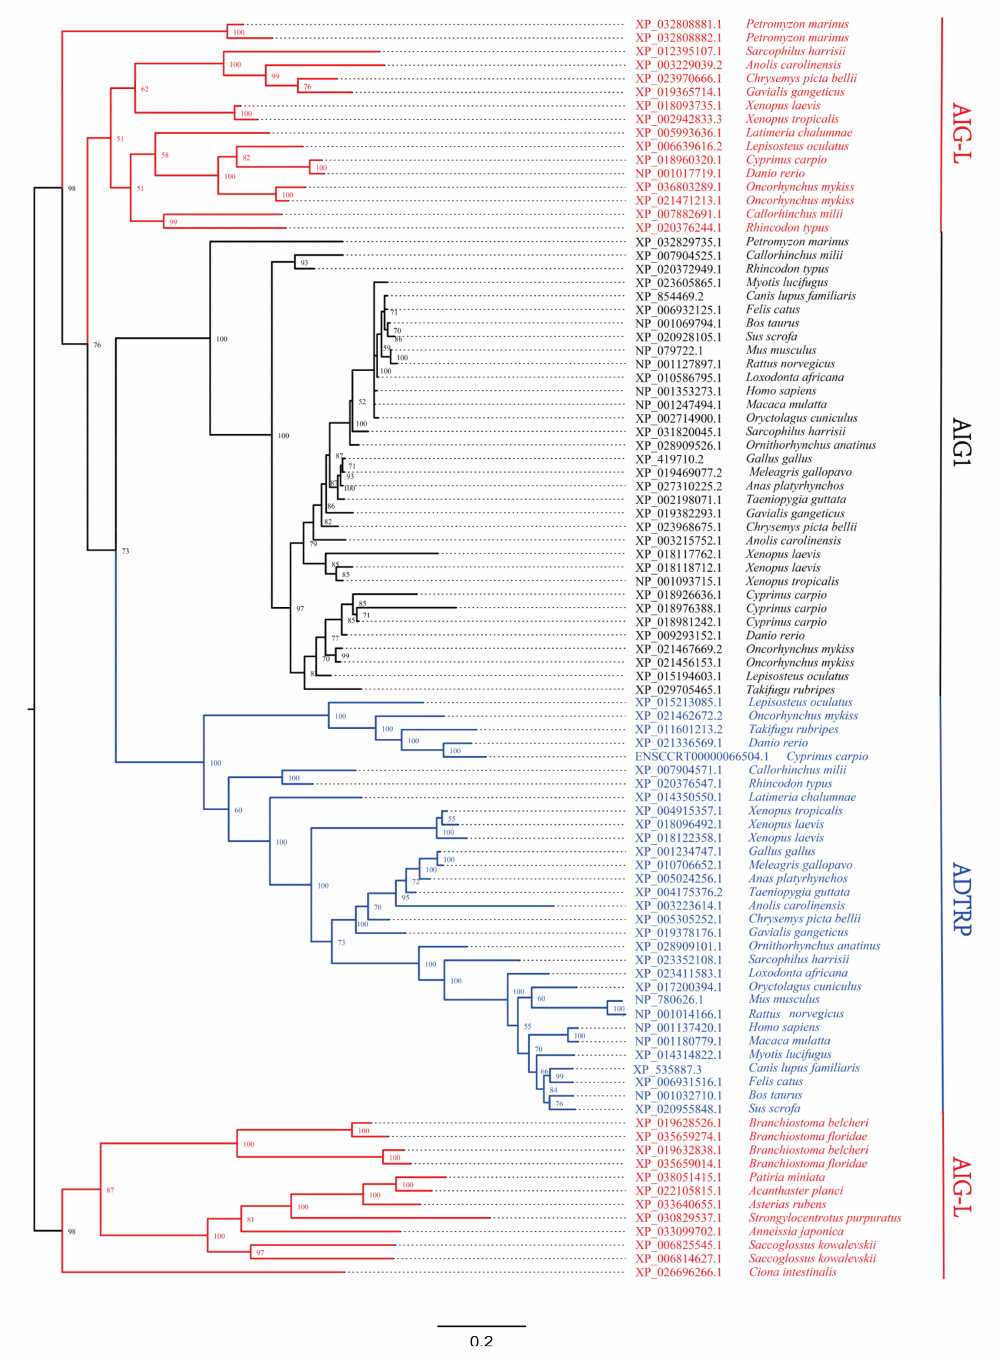
Figure 1. Phylogenetic analysis of the AIG protein sequences in representative species using Bayesian methods. The Bayesian posterior probabilities ( × 100) are shown for each node. The phylogenetic tree shows a topology with three major clades present in vertebrates. ADTRP, AIG1, and AIG-L are highlighted in blue, black, and red, respectively. Invertebrate AIG-L, which is in red, was used to generate an outgroup. Three similar phylogenetic trees generated using either Bayesian or maximum likelihood approaches are shown in Figures